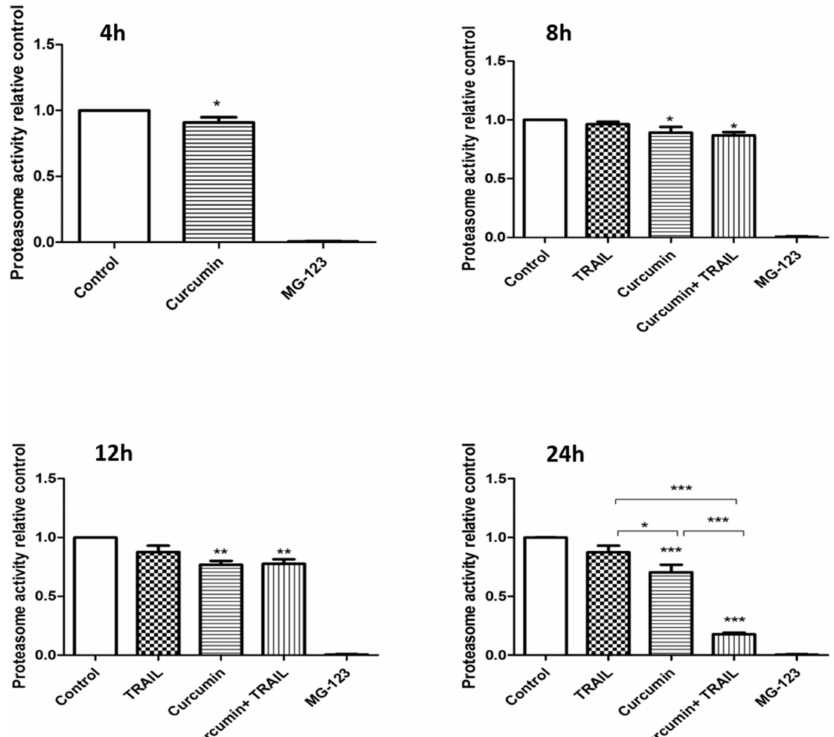
Figure 7. E ff ect of curcumin, TRAIL, and curcumin + TRAIL combination on proteasome activity in ACHN cells. ACHN cells were cultured on six-well plates incubated with culture medium containing 0.05% DMSO or 25 µ M curcumin for 4 h. Following this, cells were either analysed or further incubated with culture medium or 50 ng / mL TRAIL for 4, 8, 12 and 24 h. following the incubation period, cells were broken in lysis bu ff er. Lysates were incubated for 1 h with 100 µ M of SUC-LLVY-AMC fluorogenic substrates specific for 20S subunit of proteasome. The release of (7-amino-4-methyl-coumarin) AMC was fluorometrically measured using an excitation wavelength of 360 nm and an emission wavelength of 475 nm. The assay was run over a period of 60 min (60 cycles, one measurement per min) at 37 ◦ C. To ensure that the observed activity was indeed proteasome derived, 10 µ M MG-132 was added to another technical replicates of the vehicle- treated cell lysate, which then served as a positive control for the assay. The results were normalized for protein contents using BCA protein assay and presented as mean ± SEM of three independent experiments. *, ** and *** indicate statistically significant di ff erences relative to the control at p < 0.05, 0.01 and 0.001, respectively. One-way ANOVA was used to analyse the